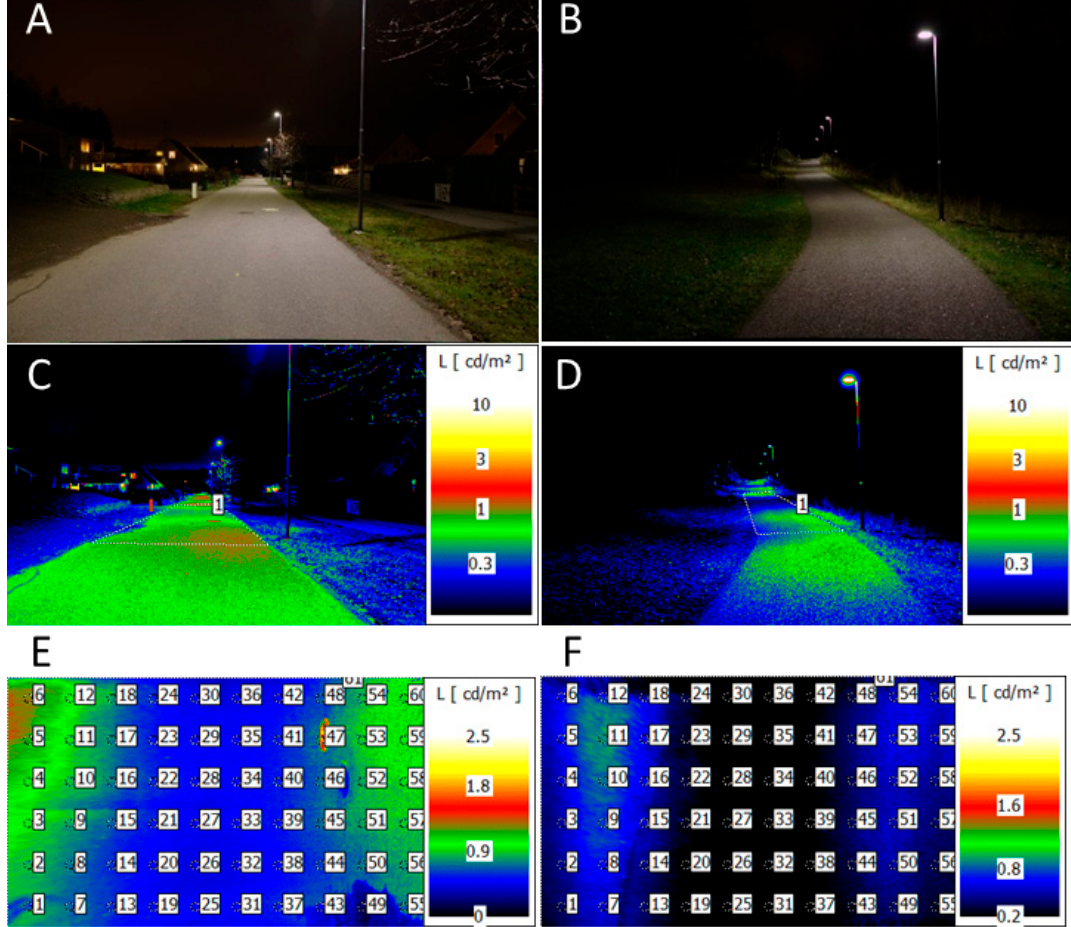
Figure 3. Photos and luminance photos and evaluations of ( left ) Vreta Gårds väg ( A , C , E ) and ( right ) Tullingeberg GC ( B , D , F ) (pedestrian and bicycle road). Luminance photos and evaluations have false colours. The luminance scale is individual and is therefore shown in each photo and evaluation. Photos were taken with a Canon EOS 550D (zoom 17–50 mm, F2.8; F4, ISO 100) set 150 cm above the ground on a tripod.